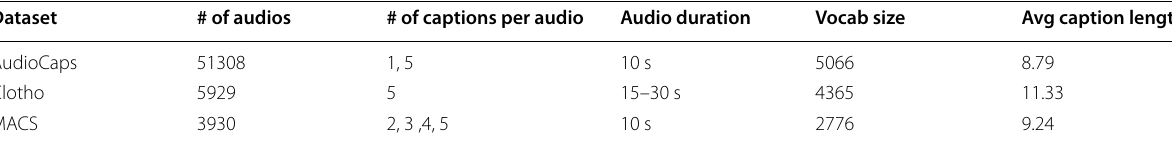
Table 2 An overview of English-annotated datasets